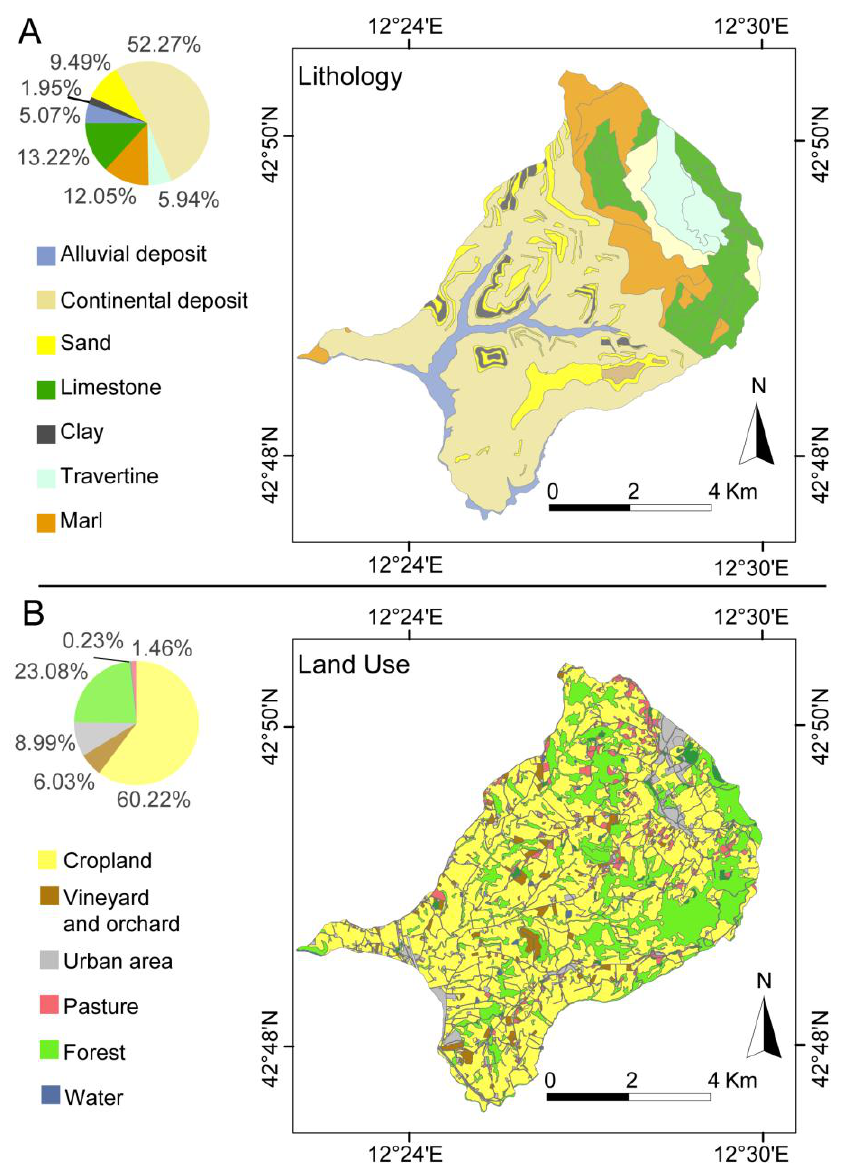
Figure 2. ( A ) Simplified lithological map and pie chart for the study area, modified after Servizio Geologico d’Italia [39]. The figures represent the percentages of the lithologies that are present in the study area. ( B ) Land use map and pie chart for the study area. The figures represent the percentages of the soil use in the study area.